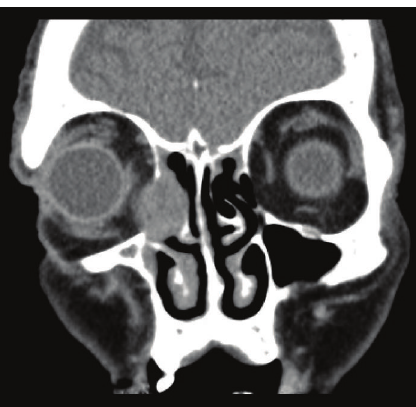
Figure 3: Endoscopic view demonstrating a pale, polypoid-like mass, covered by a papillary surface, protruding from the middle